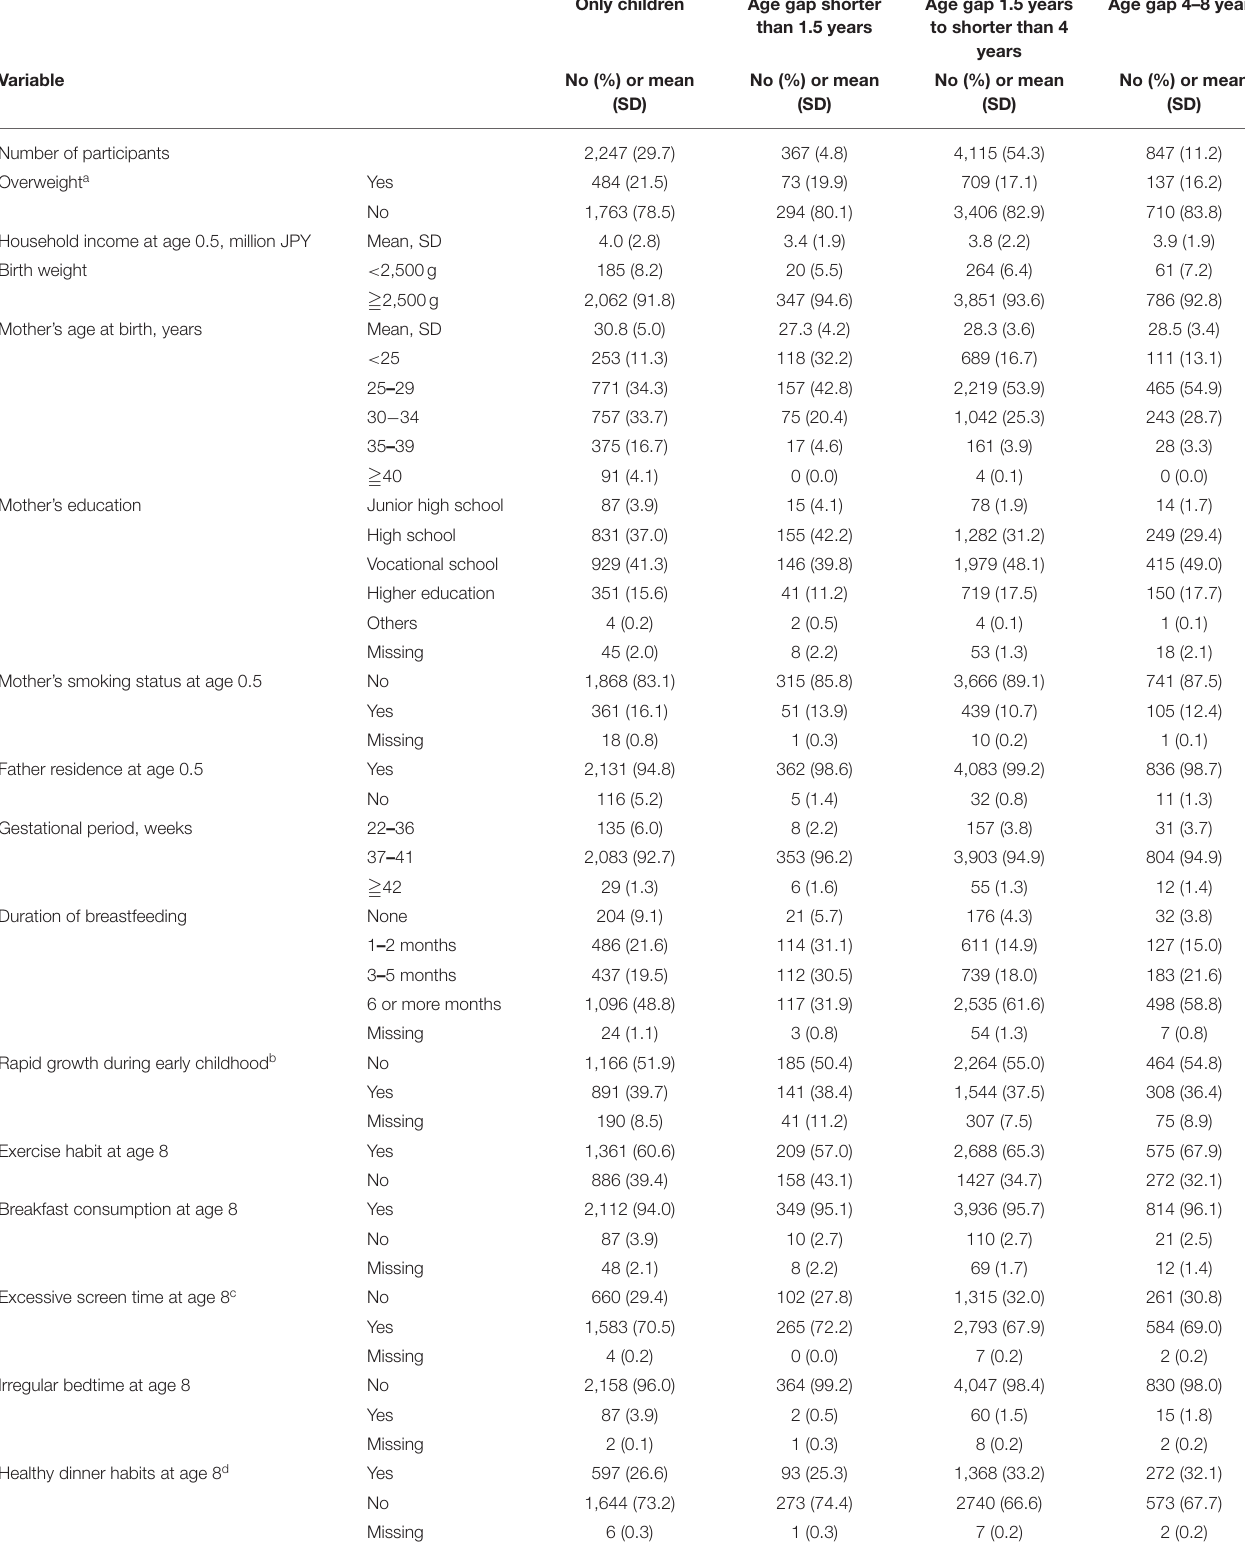
TABLE 2 | Characteristics of study participants from the Longitudinal Survey of Newborns in the 21st Century, 2001–2009 (boys n =